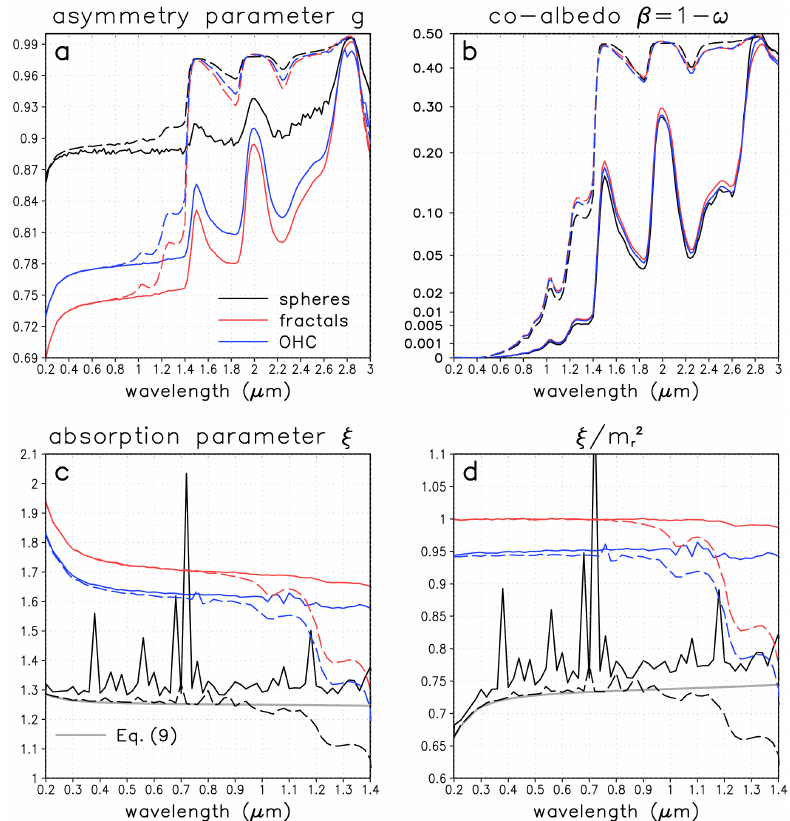
Figure 6. Comparison of single-scattering properties for spheres (black lines), distorted Koch fractals with t = 0.18 (red) and the optimized habit combination (blue), for r vp = 50µm (solid lines) and r vp = 1000µm (dashed lines), for a monodisperse size distribution. (a) Asymmetry parameter g ; (b) single-scattering co-albedo β = 1 − ω ; (c) non-dimensional absorption parameter ξ (Eq. 8); and (d) ξ divided by the real part of refractive index squared. In ( c and d ), the grey line represents Eq.